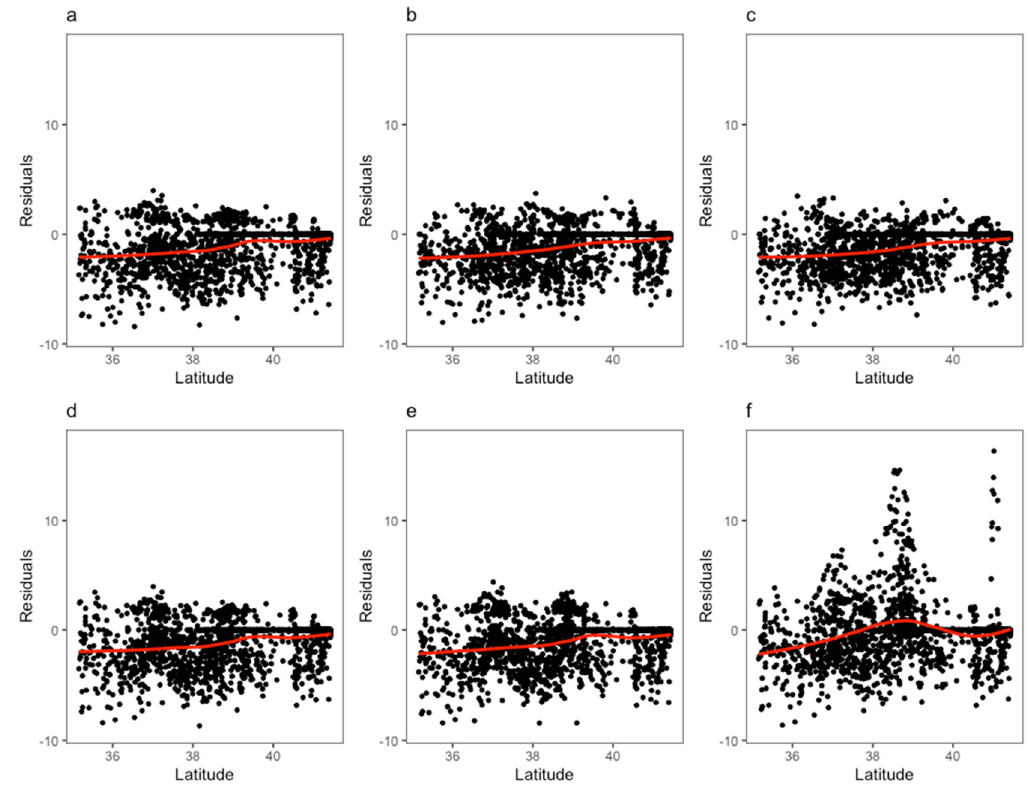
Figure 6. Moving average of residuals over latitude for six candidate models (( a ) residuals from delta GLM; ( b ) residuals from delta GAM; ( c ) residuals from Delta spatial GAM; ( d ) residuals from delta SAR error model; ( e ) residuals from delta SAR lag model; ( f ) residuals from delta SAR mixed